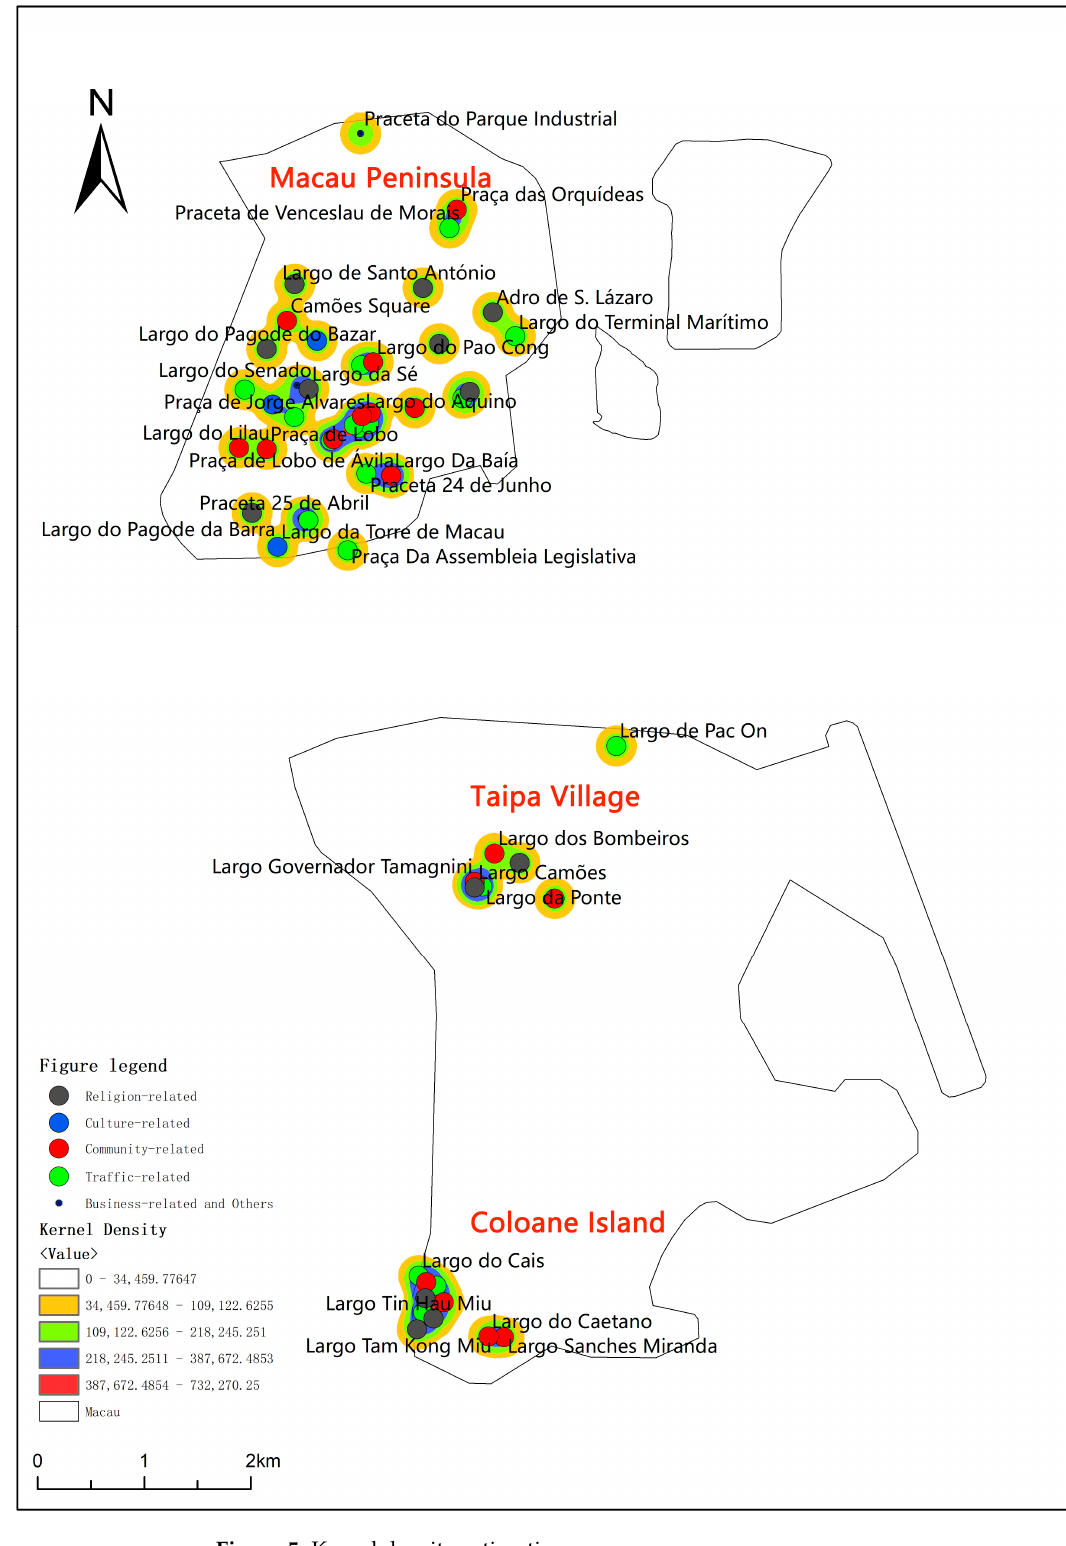
Figure 5. Kernel density estimation.